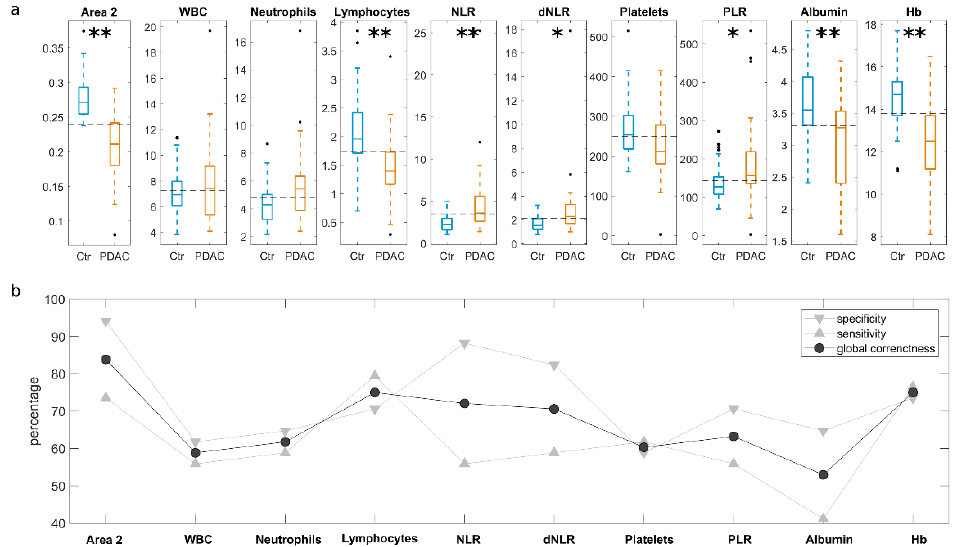
Figure 2. ( a ) Boxplots of electrophoretic and clinical parameters for PDAC patients (orange) and control (i.e., non-oncological) subjects (blue) sample distributions. Whiskers span from the mini- mum to the maximum measured values, and boxes indicate the 25th–75th percentile range and horizontal segments represent the median values of the distributions. Asterisks correspond to Stu- dent’s t-test p -values: * p < 0.05; ** p < 0.001. ( b ) Specificity, sensitivity and global correctness of the test’s discrimination ability for each of the investigated parameters.